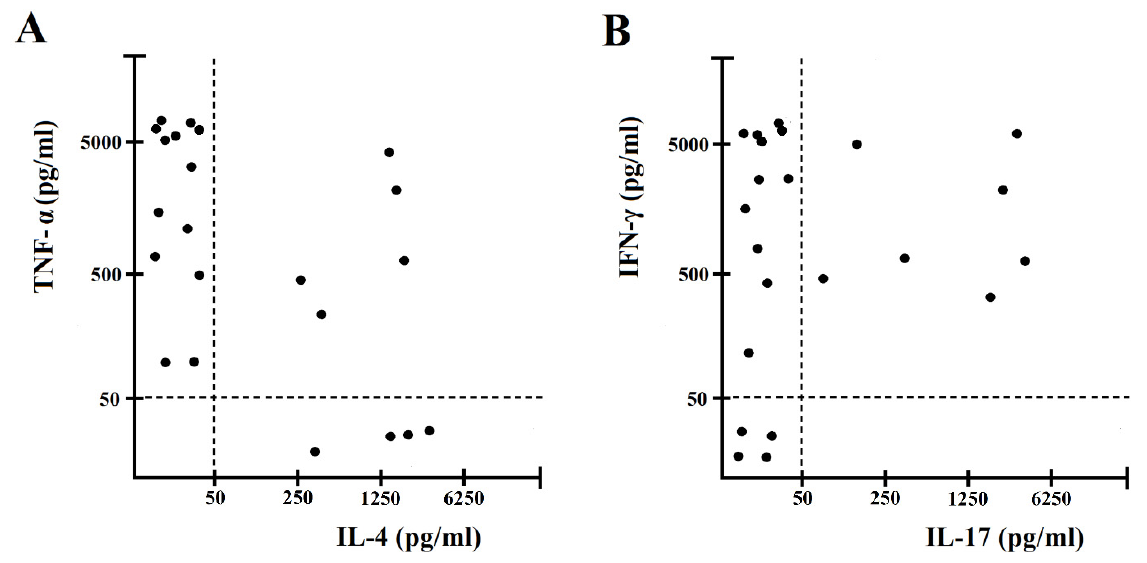
Figure 2. Cytokine profile of gastric mucosa CagY-specific CD4 + T cell clones obtained from H. pylori -infected patients with gastric low-grade MALT lymphoma. Th clones were tested for cytokine production ( A , B ). CagY-specific Th clones were stimulated with CagY and TNF- α and IL-4, IFN- γ and IL-17 production was measured in culture supernatants. In unstimulated cultures, levels of TNF- α , IL-4, IFN- γ and IL-17 were consistently < 20 pg/mL. CD4 + T cell clones producing IFN- γ , but not IL-17 nor IL-4, were coded as Th1. CD4 + T cell clones producing IL-17, but not IFN- γ nor IL-4, were coded as Th17. CD4 + T cell clones producing IFN- γ , and IL-17, but not IL-4, were coded as Th17/Th1. CD4 + T cell clones producing TNF- α and IL-4, but not IL-17, were coded as Th0.